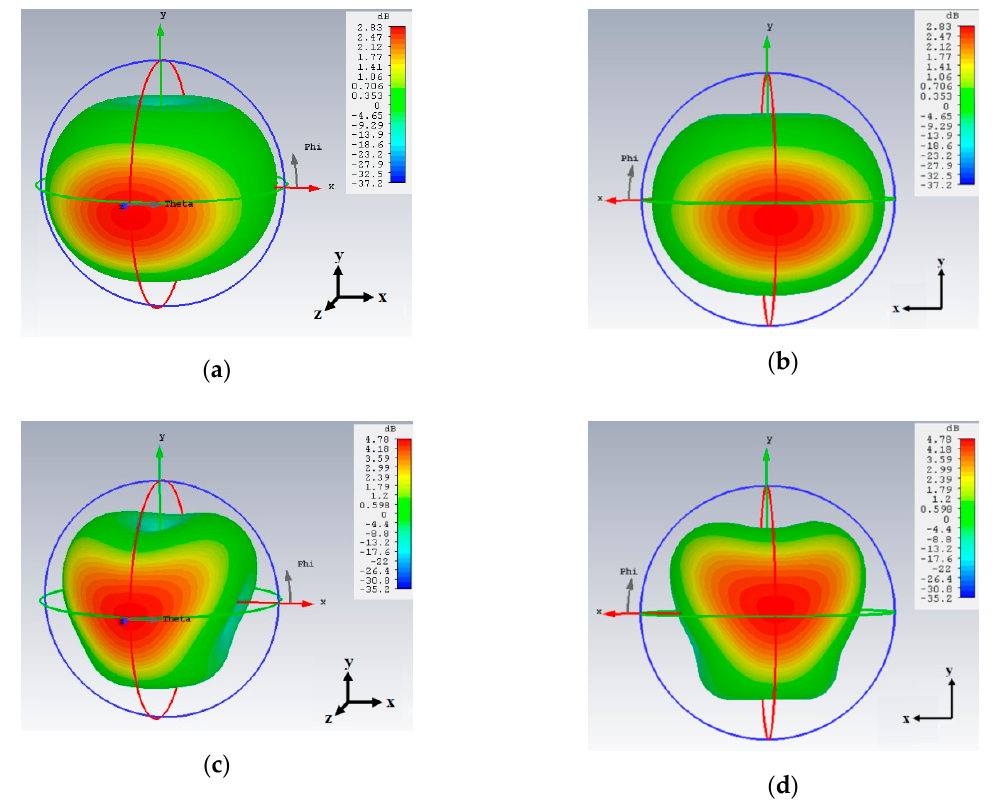
Figure 4. 3D realized gain patterns of Antenna_1: At 868 MHz, views from ( a ) in front of the antenna’s plane and ( b ) at the back of the antenna. At 1.8 GHz, ( c ) in front of and ( d ) at the back of the antenna.